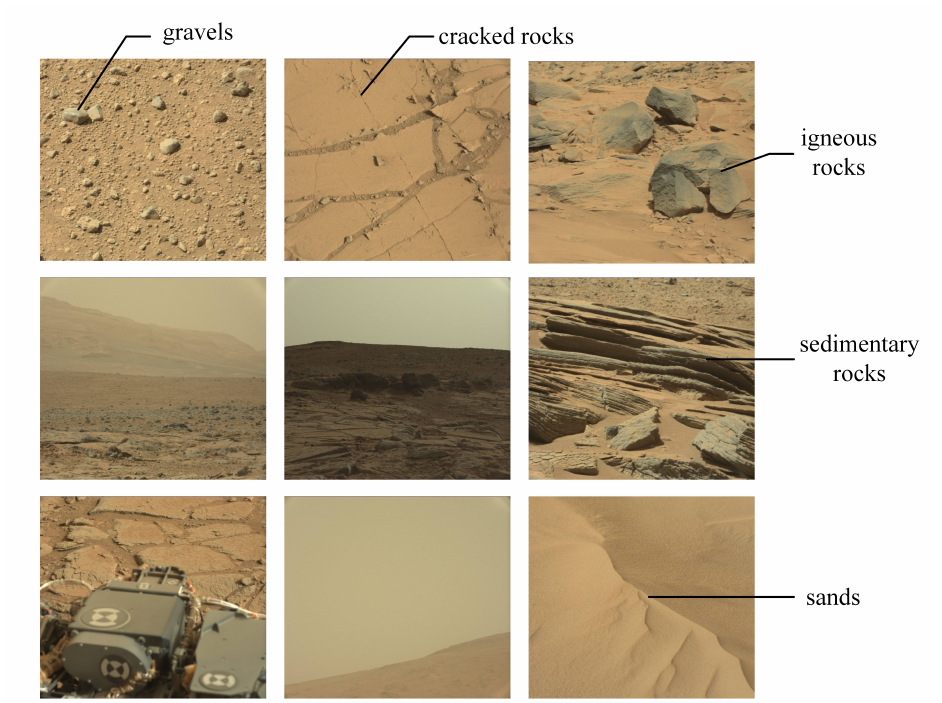
Figure 6. Snapshots of mars32k. We exhibit five representative small-field images, three wide-field images and one image with Curiosity‘s